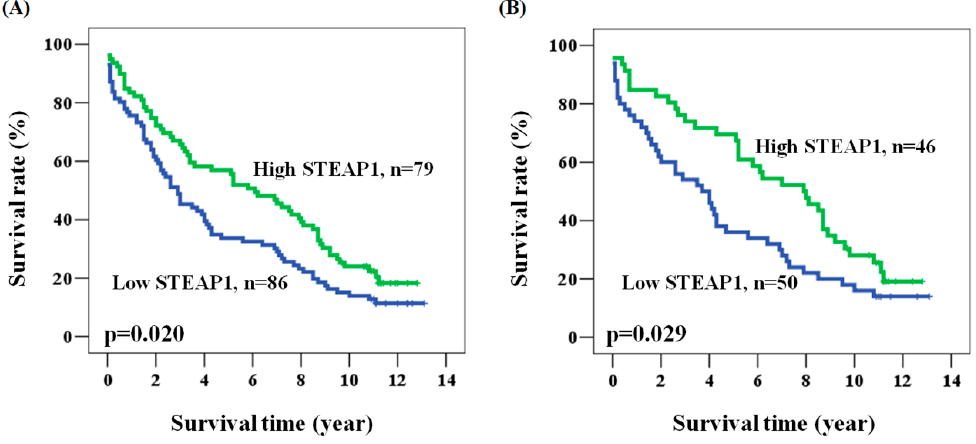
Figure 2. Kaplan-Meier actuarial analysis of STEAP1 expression in overall survival of patients with ( A ) all subjects; and ( B ) N0. Table 4. Multivariate analysis of the influence of STEAP1 expression in subgroups according to clinical parameters on overall survival in colorectal cancer patients.